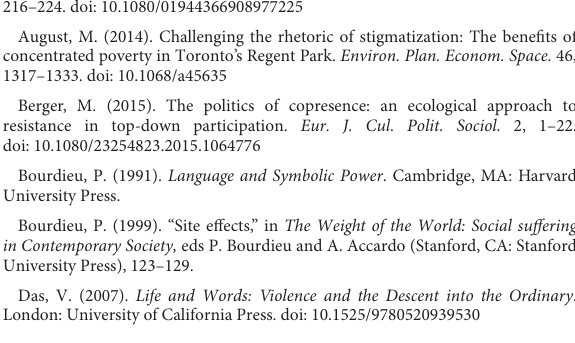
Race, Respectability, and